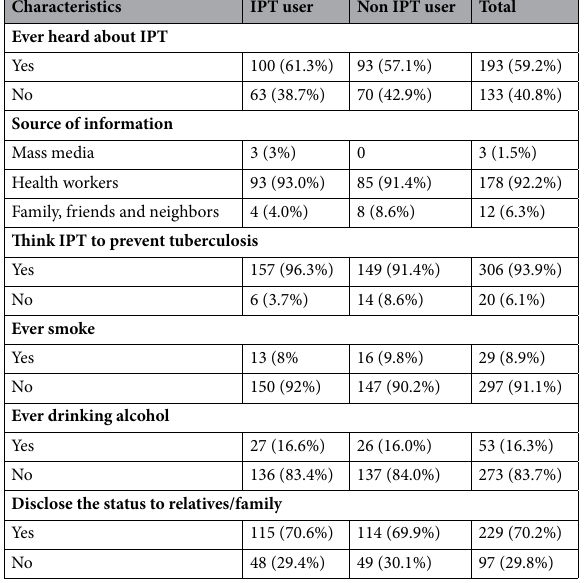
Table 3. Knowledge and attitude on isoniazid preventive therapy and behavior-related characteristics of PLWHIV in Dessie city administrative